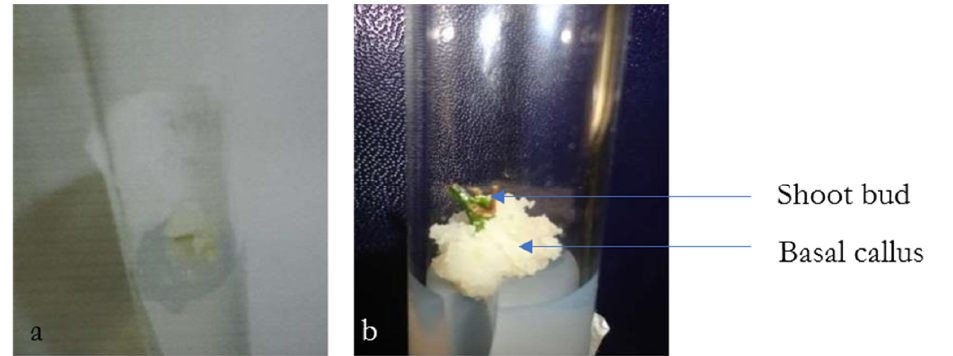
Figure 4. Callus and basal callus with shoot induced from stem and nodal explant of E. cyclocarpum after four weeks of culture respectively on MS Supplemented 5.4 µM NAA + 4.4 µM BA for the